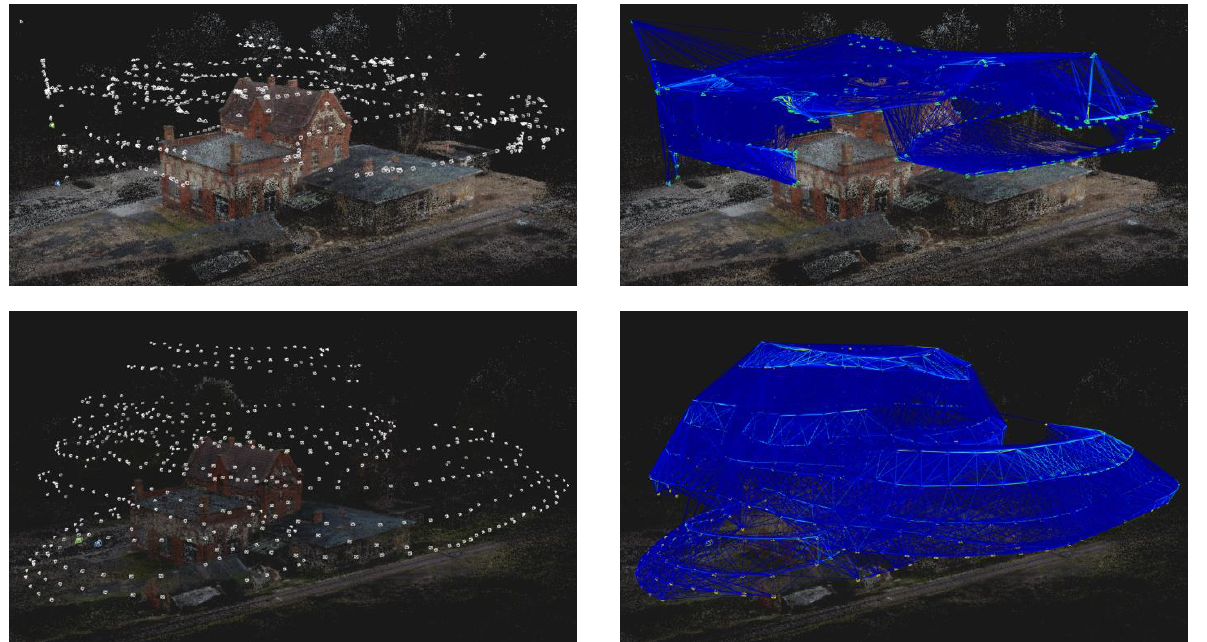
Figure 17: Comparison of image configurations resulting from a manually piloted attempt using time interval camera triggering (top) and from tests using our flight planning and assistance tools (bottom). In the former case, distances and viewing directions were not realised adequately. The distribution of camera stations (left) exhibits holes as well as clusters and results in suboptimal image connectivity (right). Using our approach, the results are significantly